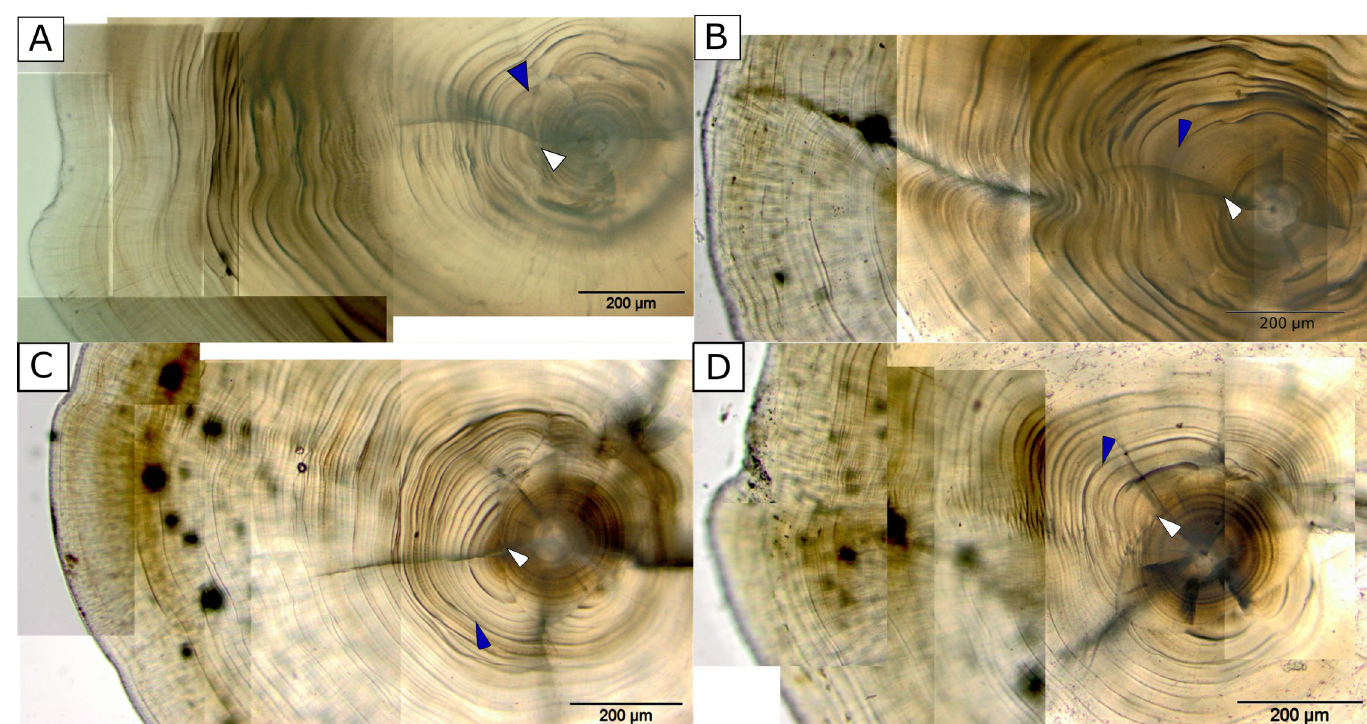
Fig 2. Otolith images of juvenile common sole obtained at 200X magnification used for ageing through the Smartdots software: A ) UK; B , C ) Belgian and D ) Dutch examples. The images are the result of stacking multiple images taken through an Olympus BX53 microscope after subsequent polishing steps to allow for a good visualization throughout the otolith. The white arrow points to the start of metamorphosis, i.e. the end of the larval phase and the initiation of the metamorphosis phase; the blue arrow points to the end of the metamorphosis coinciding with the settlement event. The number of increments between the hatch check and the end of metamorphosis (blue arrow) represents the entire pelagic larval duration